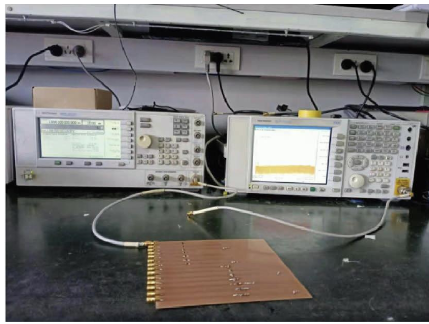
Figure 11: Measuring environment of the proposed test board.